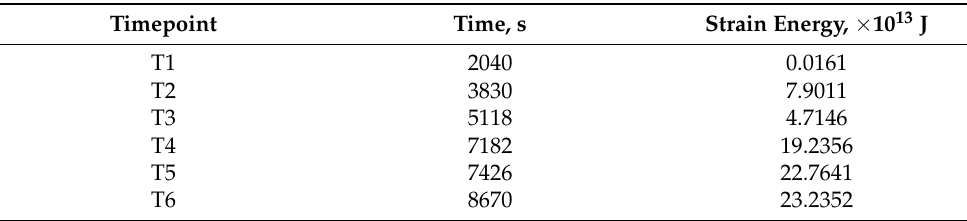
Table 3. Time intervals during the formation and evolution of normal fault.